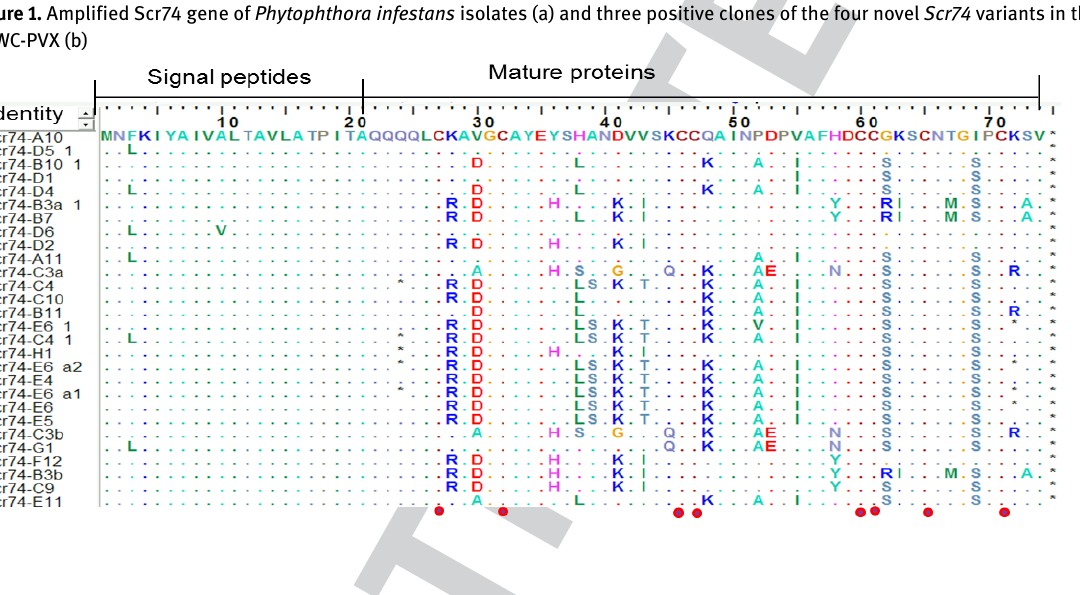
Figure 2. One letter representation of 74 amino acid sites in multiple sequence alignment from 28 Scr74 variants. The signal peptide starts from amino acid sequence 1 – 21 and the rest (from 22 - 74) are mature proteins, the symbol * in the sequences site indicates stop codon of pseudogenes, at the bottom indicates cycteine amino acid sites and on the side indicates effectors which do not have many diversified amino acid